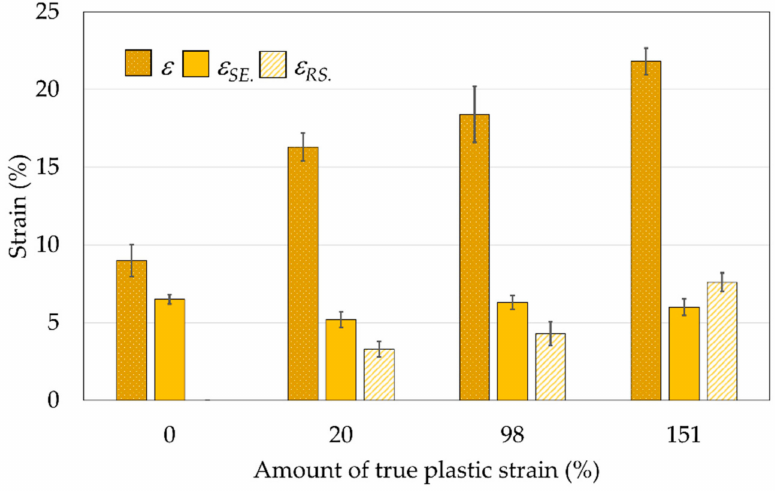
Figure 12. Elongation after fracture ( ε ), strain recovery ( ε SE. ) and residual strain ( ε RS. ) as a function of true plastic strain ( ϕ g